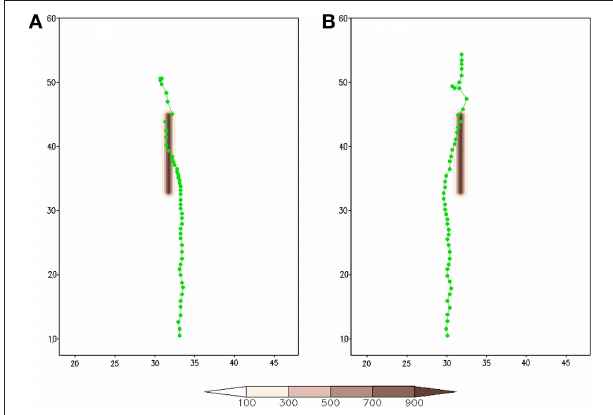
FIGURE 13 | The TC tracks for (A) Track B and (B) Track C. The units of the coordinates in the x and y directions are